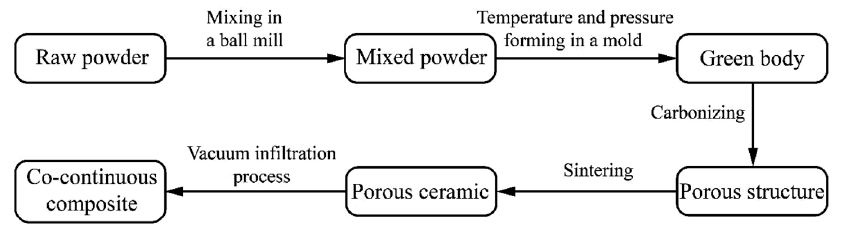
Fig. 1 Flow chart of the preparation of co-continuous